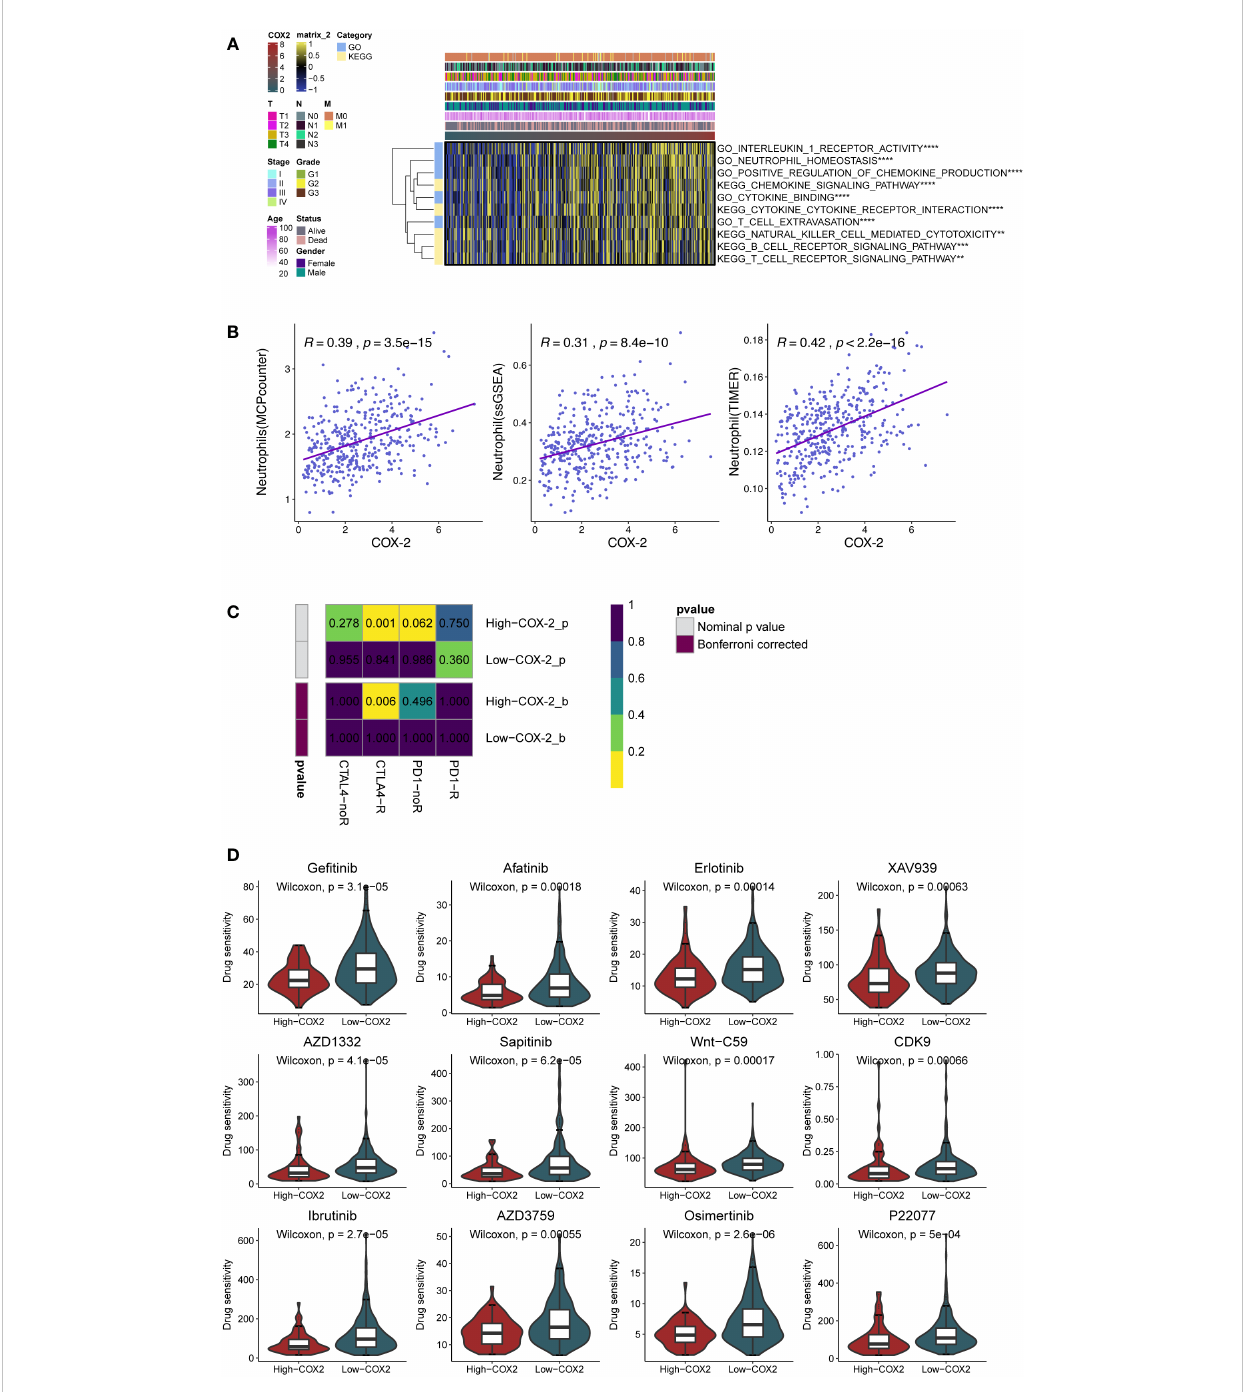
FIGURE 3 COX-2 is associated with immunocyte in fi ltration and immunotherapy. (A) The GSVA analysis of the processes related to the immune reaction. (B) The relationship between the expression of COX-2 and neutrophil in fi ltration in gastric cancer was analyzed by MCPcounter algorithm, single sample genome enrichment analysis (ssGSEA) and TIMER database. (C) The submap analysis between immunotherapy responses (anti-PD-1 and anti-CTLA-4) and COX-2 levels in TCGA-STAD. (D) The evaluation of drug sensitivity in different COX-2 levels based on GDSC